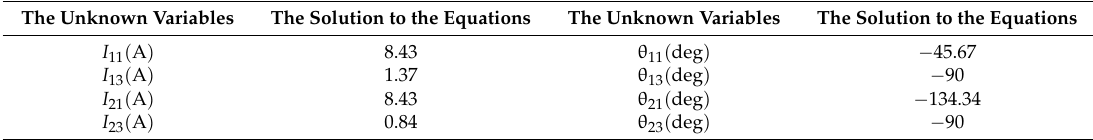
Table 6. The optimum solutions to the fault-tolerant current under single-phase open-circuit fault type in outer